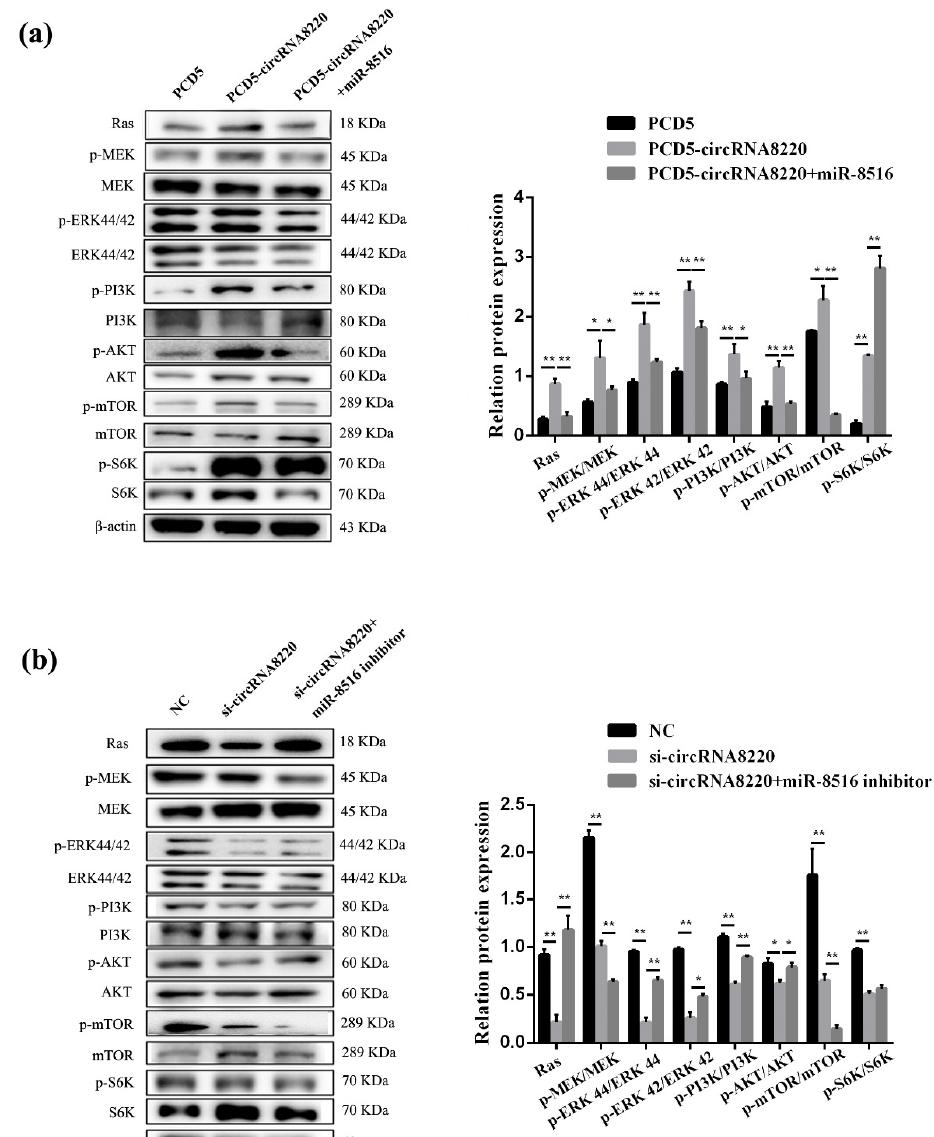
Figure 9. circRNA8220 activated the signaling pathways of Ras / MEK / ERK and PI3K / AKT / mTOR in GMEC. ( a , b ) Western blot analysis was performed to detect the protein expression of Ras, p-MEK, MEK, p-ERK44 / 42, ERK44 / 42, p-PI3K, PI3K, p-AKT, AKT, p-mTOR, mTOR, p-S6K, S6K and β -actin in GMEC after transfection with PCD5-circRNA8220 or si-circRNA8220. Protein levels were measured by WB densitometry was normalised to the β -actin density from the same lane. Data were expressed as the means ± SEM. ** p < 0.01, * p < 0.05.